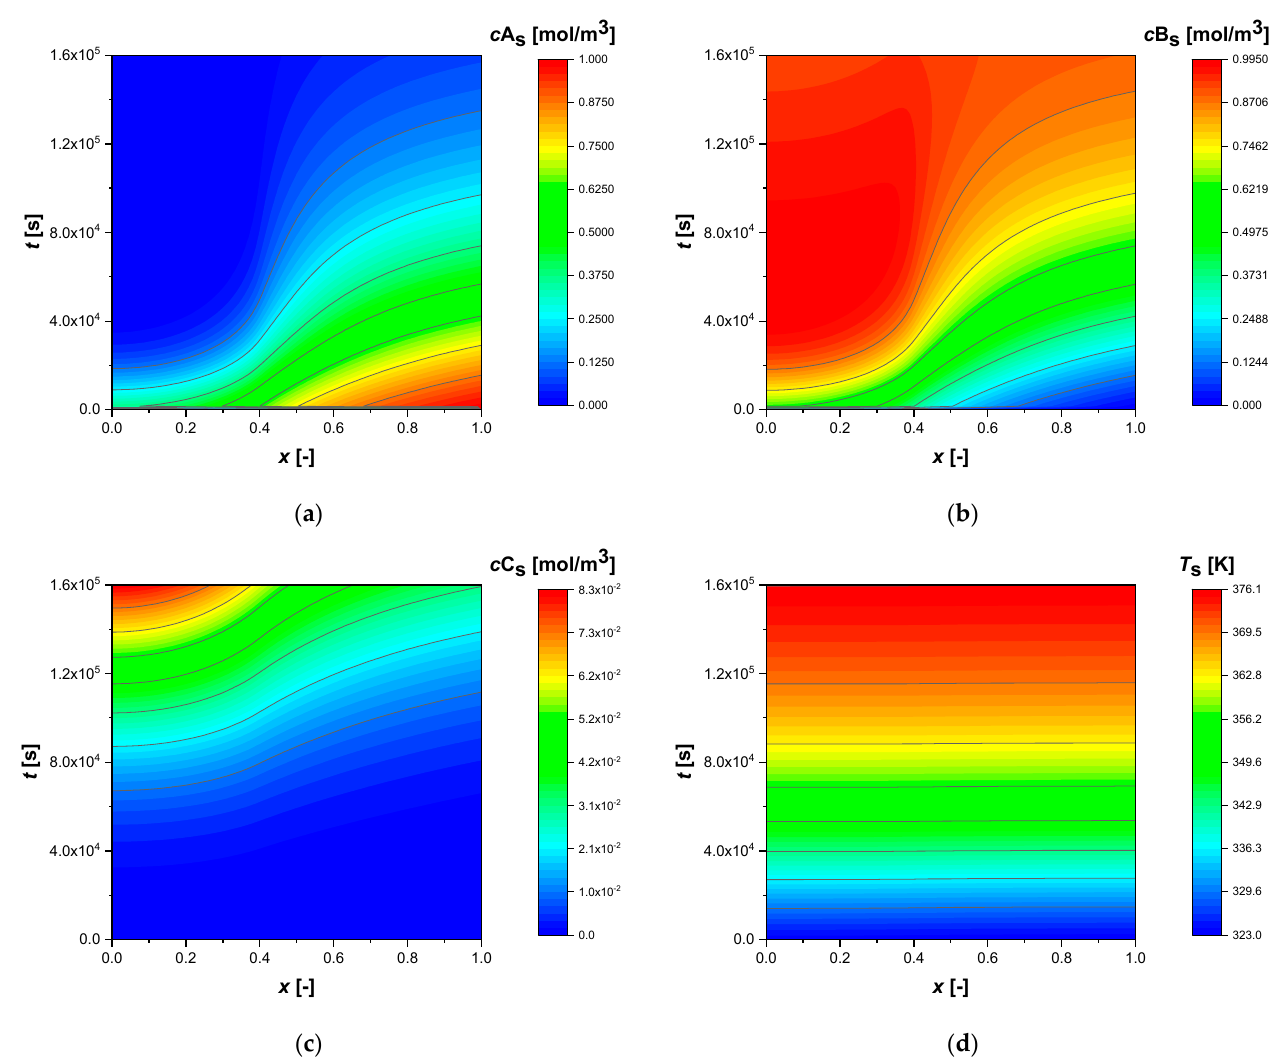
Figure 3. Intraparticle profiles for EY catalyst. Calculated profiles for: cA ( a ), cB ( b ), cC ( c ), and Ts ( d ). Color-bar of each plot is located on the right-hand-side.